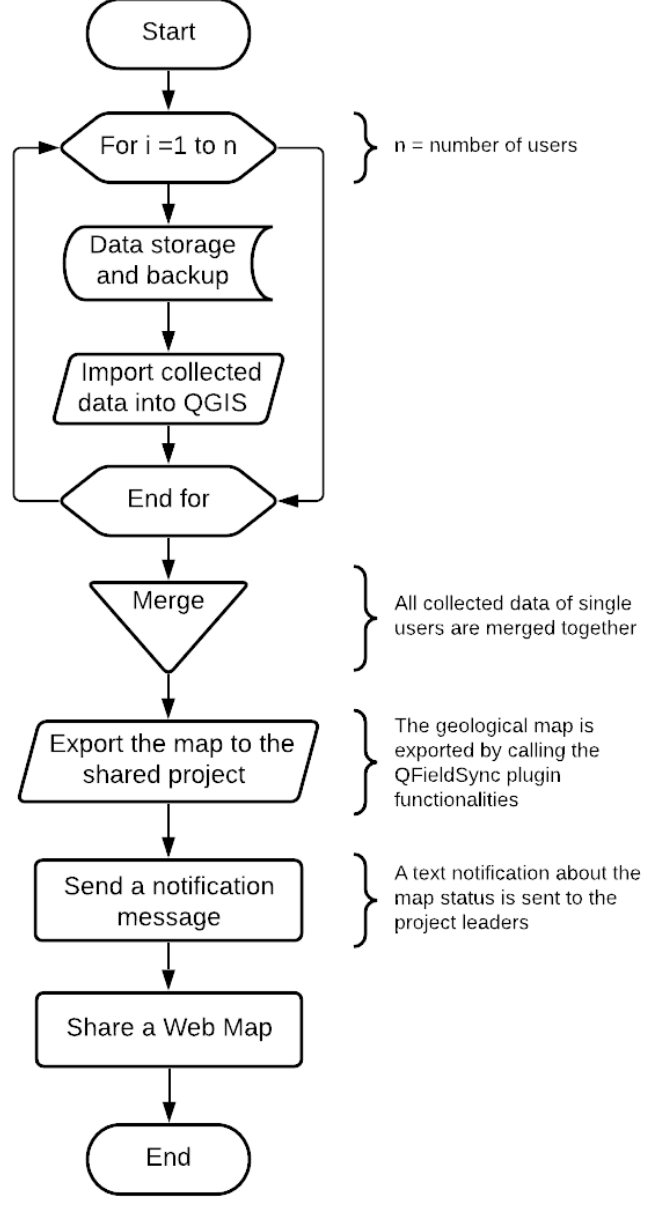
Figure 2. Flowchart of the developed algorithm with its main